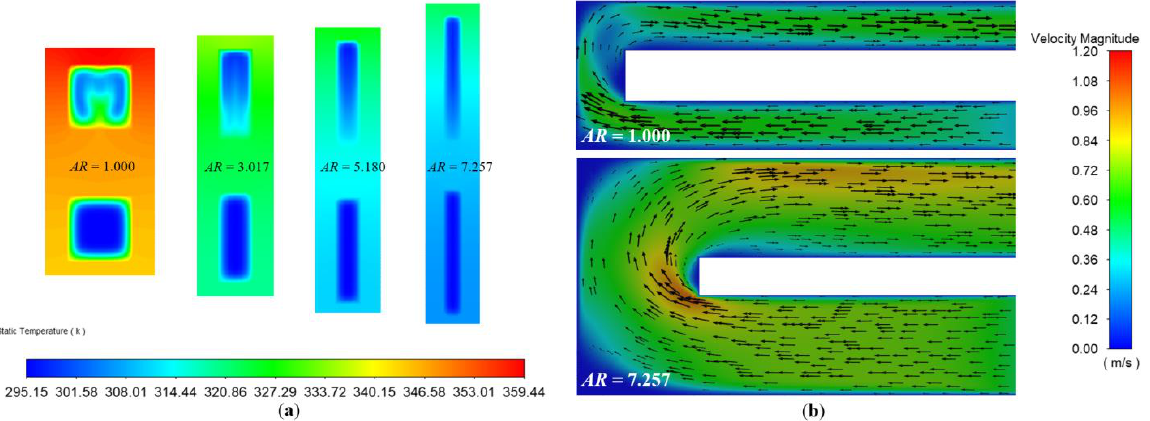
Figure 5. The temperature distribution of the microchannel heat sinks at a distance of 3 mm along the x-direction with different aspect ratios ( a ) ( Re = 200, Temperature unit: K). The velocity flow diagram of the microchannel heat sinks with different aspect ratios ( b ) ( Re = 200, Velocity unit: